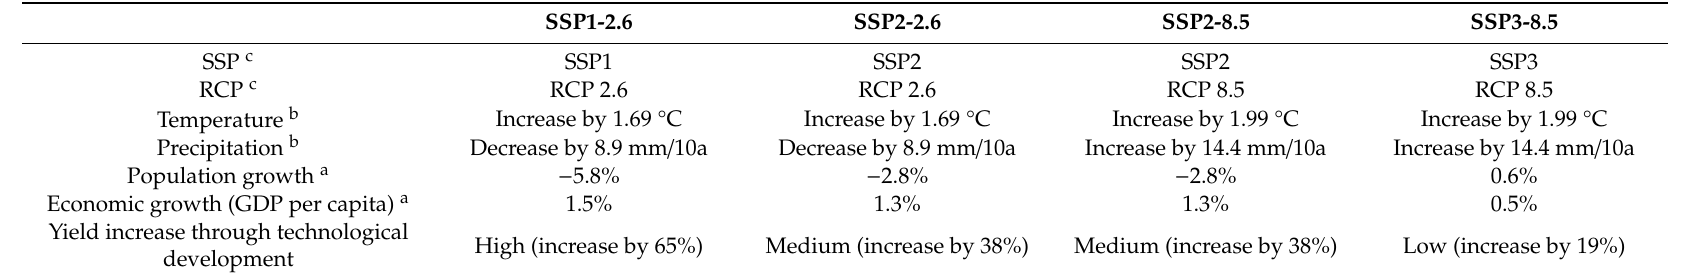
Table 1. Quantitative projections for the 2050 scenarios with a 2004 baseline